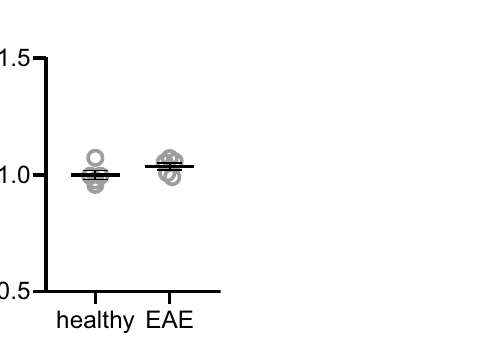
Figure 4. Glibenclamide, not 9-phenanthrol, reduces EPSP peak amplitude in CA1 pyramidal neurons in EAE mice. ( a ) EPSPs recorded from a representative CA1 pyramidal neuron in response to stimulation of stratum radiatum in an acute slice from a Trpm4 + / + mouse prepared during the acute response to EAE. After establishing a stable baseline (blue trace), 9-phenanthrol (30 μM, 9-P) was washed into the bath for 20 min (black trace). ( b ) Normalized average EPSP peak and area under the curve (AUC) at baseline (average 5 min) and after wash-in of 9-phenanthrol (average 15–20 min) (n = 4, individual experiments, mean ± SEM). ( c ) As in a but black trace is after wash-in of glibenclamide (20 µM, Glib). ( d ) As in B but before and after washing in glibenclamide (n = 8, individual experiments, mean ± SEM, *p = 0.02 Wilcoxon paired test). ( e ) As in C but example EPSPs were recorded before (orange trace) and after washing in glibenclamide (black trace) onto a CA1 neuron in a slice made from a Trpm4 -/- EAE littermate. ( f ) As in D but from Trpm4 -/- littermates (n = 7, individual experiments, mean ± SEM). Non-normalized data and Cumming’s plots are in Supplemental Fig. 2.